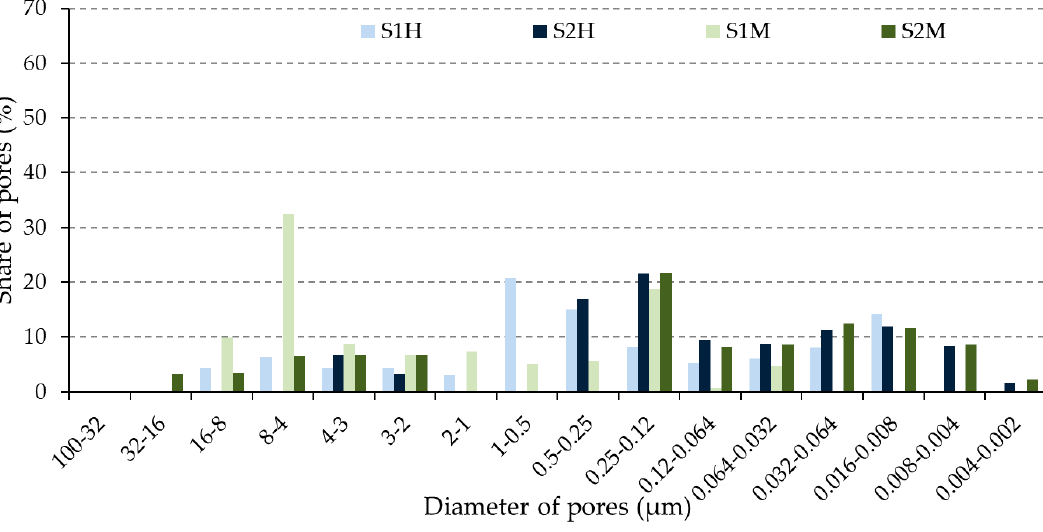
Figure 5. Pore-size distribution in the unfired bricks.